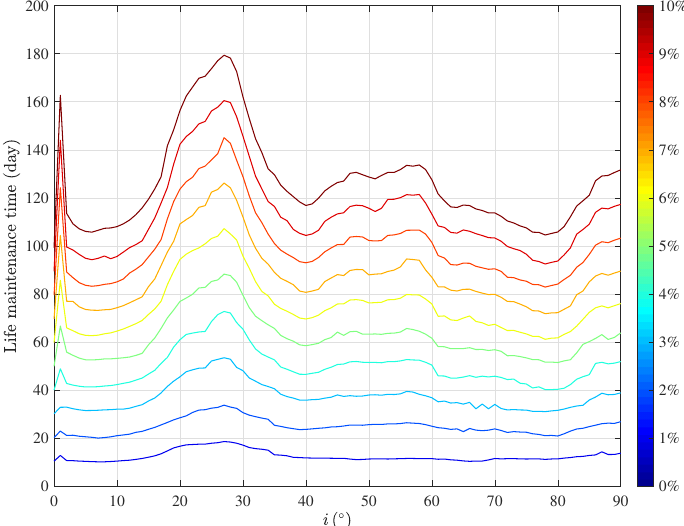
Figure 11. The plot of initial inclination verses life maintenance time with initial Ω = 240 ◦ . The horizontal axis is the initial inclination of the Lunar spacecraft, and the step of scanning the inclination is 1 ◦ . the vertical axis represents the life maintenance time. the different colors of solid lines indicate different ratios of fuel consumption. the index of the fuel ratio can be found in the color bar on the right side. As the color bar illustrates, the blue line shows the tendency of orbit maintenance days versus initial inclination with 1% fuel, while the red line shows the same situation with 10% fuel. With the same initial conditions, the lifetime can be maintained longer with more fuel. Local maximum values in the tendency of spacecraft lifetime vary with the inclination. the lifetime can be maintained longer when the initial inclination is i = 1 ◦ , i = 27 ◦ , i = 48 ◦ , i = 58 ◦ or i = 90 ◦ . These values of the initial inclination are in the neighborhood of frozen orbit inclination; the